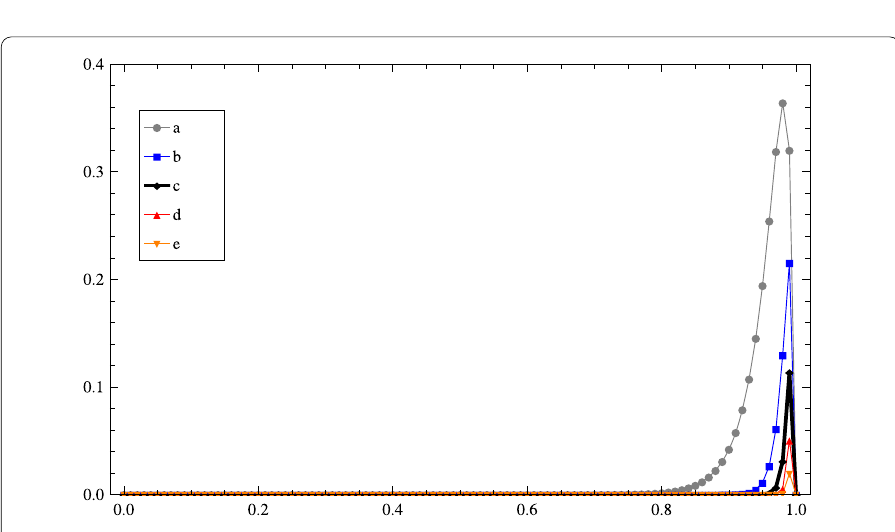
Figure 10 a : ε 10,20 ( x ), b : ε 20,30 ( x ), c : ε 30,40 ( x ) and d : ε 40,50 ( x ) for ν 0 = 0, λ = 10, ... ,50 and n = 1 in